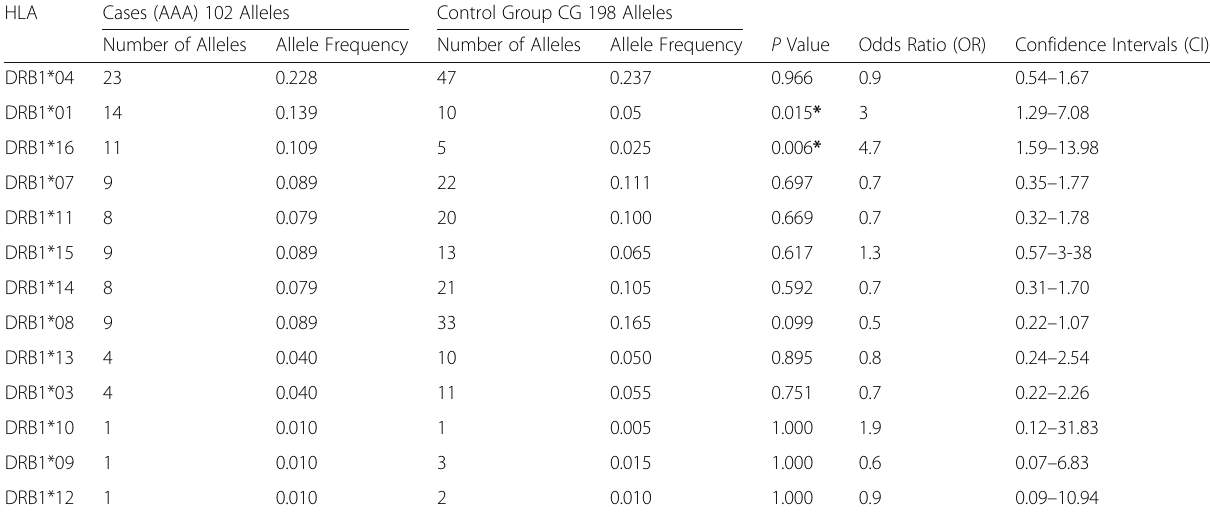
Table 2 Allele frequencies of HLA-DRB1 locus in Mexicans Mestizo patients with Abdominal Aortic Aneurysm (AAA) and control group (CG)